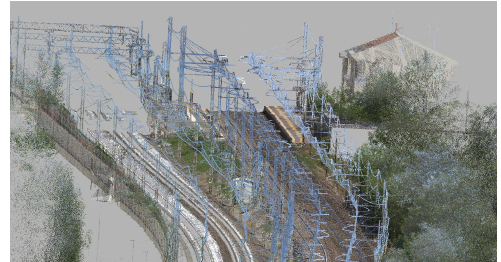
Figure 1. Example of train mobile mapping point cloud acquired in proximity of a station.